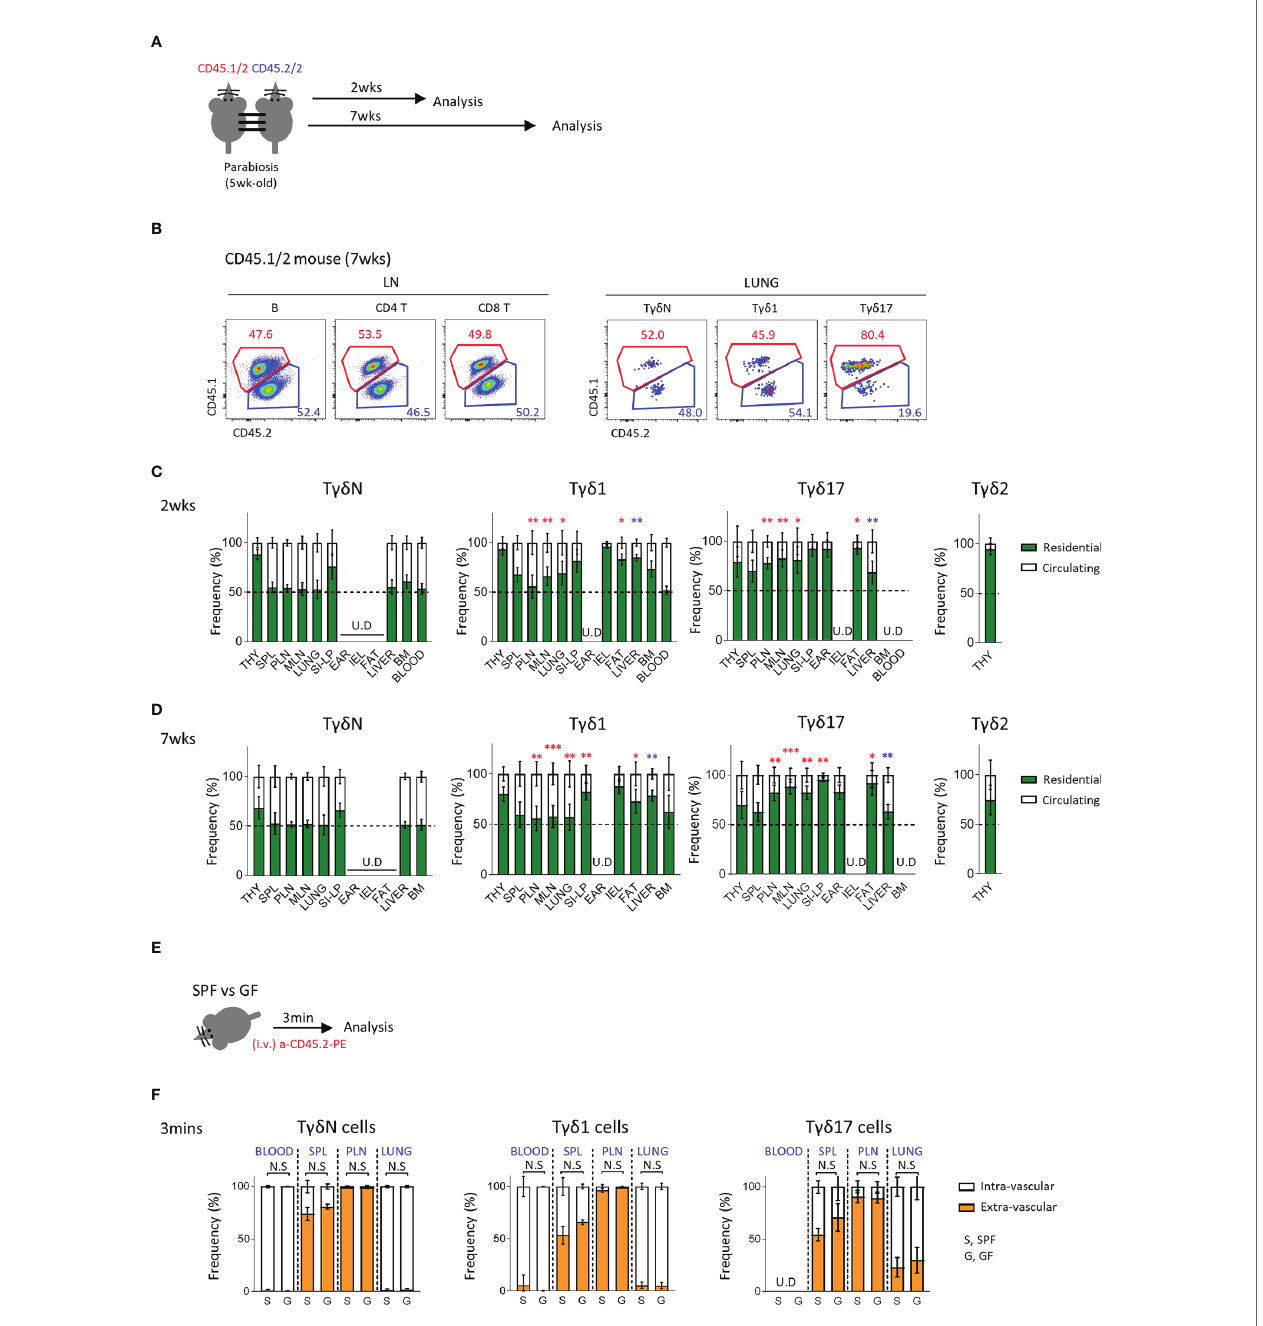
FIGURE 3 | T gd 17 cells are tissue resident. (A) Experimental scheme illustrates parabiosis schedules. Five week-old CD45.1/2 and CD45.2/2 congenic B6 mice were underwent parabiosis surgery and analyzed after 2- and 7- weeks. (B) Representative dot plots show proportion of resident (CD45.1/2) and circulating (CD45.2/2) B (B220 + ), CD4 T and CD8 T cells in peripheral lymph nodes and T gd N, T gd 1 and T gd 17 cells in lung. Numbers indicate frequencies of cells in adjacent gates. (C, D) Bar graphs show mean frequencies of residential and circulating cells of each cell subset in indicated tissues at 2- (C) and 7-weeks (D) after parabiosis. Pooled data from three independent experiments using 3 to 5 pairs are shown. (E, F) B6 SPF and GF mice were stained with anti-CD45.2 antibody via intravenously (i.v.) injection and single cell suspensions of indicated organs were analyzed at 3 min after in vivo staining. (E) Experimental scheme is shown. (F) Bar graphs show mean frequencies of intra- and extra- vascular cells of each cell subset in indicated tissues (N = 3). Error bars indicate ± SD. U.D, undetected. Unpaired two-tailed t -test was used. *P < 0.05, **P < 0.01, ***P < 0.001. THY, thymus; SPL, spleen; PLN, peripheral lymph node; MLN, mesenteric lymph node; SI-LP, small intestinal lamina propria; IEL, intraepithelial lymphocytes; BM, bone-marrow, SPF, speci fi c pathogen free; GF,